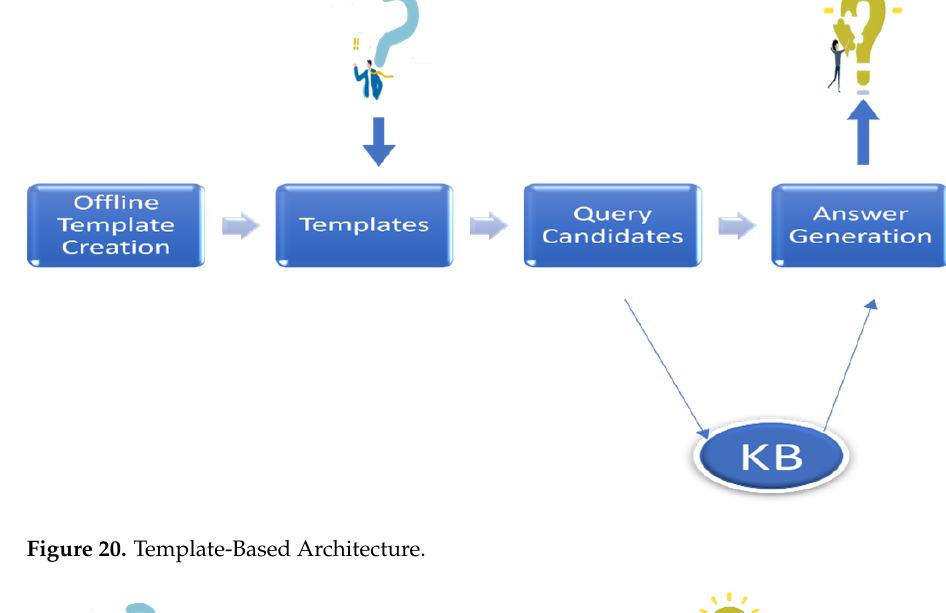
Figure 20. Template-Based Architecture.